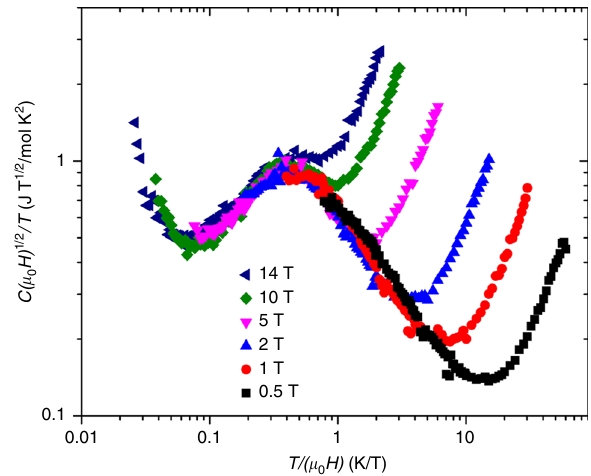
Fig. 2 Power law heat capacity in LiZn 2 Mo 3 O 8 under various magnetic fi elds. At zero fi eld the heat capacity shows a non-integer power law C / T ∼ T − 0.56 (purple line), changing under various magnetic fi elds to functional forms with quadratic C ∼ T 2 behavior (orange line) at low temperature